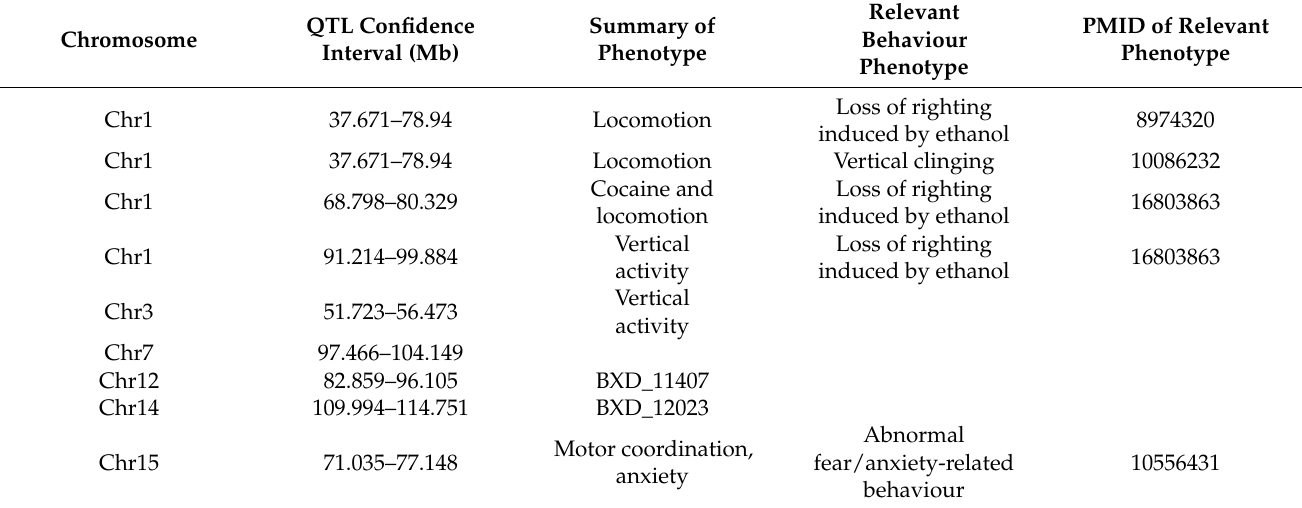
Table 1. Summary of novel QTL, not found at the significant or suggestive level in the original paper by Philip et al. [39]. The position of the QTL, a summary of the phenotypes within that QTL, and relevant phenotypes found in other studies are shown. Details of all identified QTL are in Supplementary Table S5.